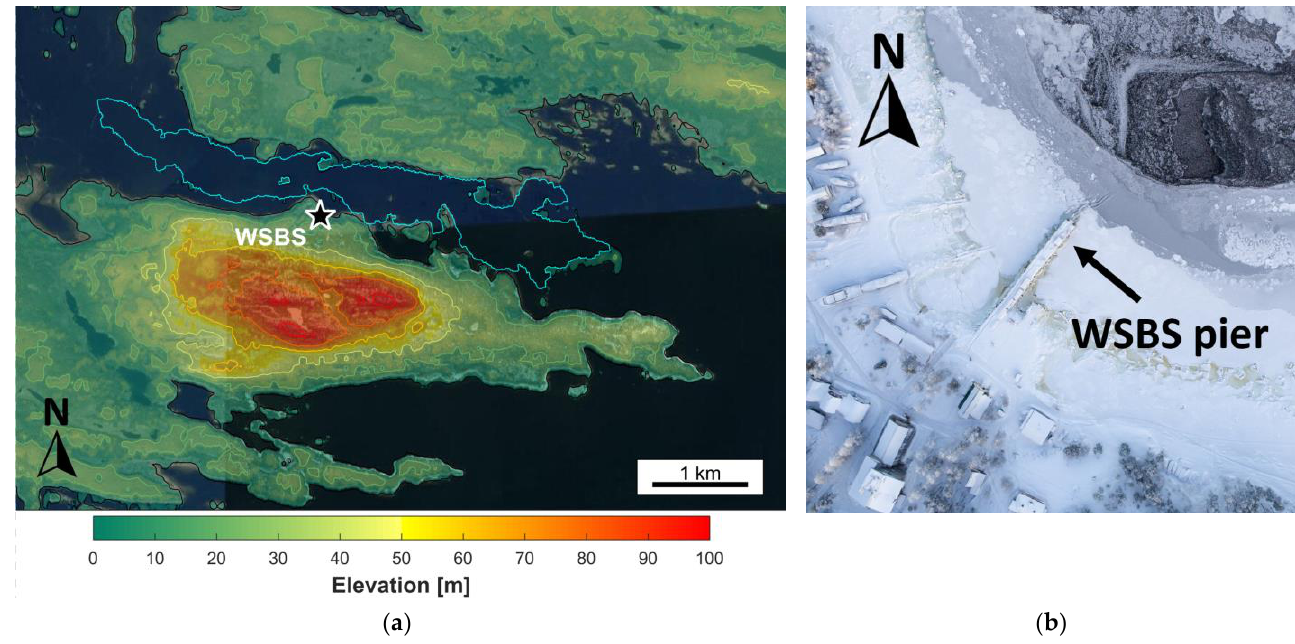
Figure 1. Location of the White Sea Biological Station (WSBS) site ( a ) and aerial photo of WSBS pier where the discussed observations were performed ( b ). Colored shading in ( a ) represents the elevation above the sea level according to Arctic DEM, and cyan line indicate the typical location of the unfreezing polynya in the Bolshaya Salma straight.